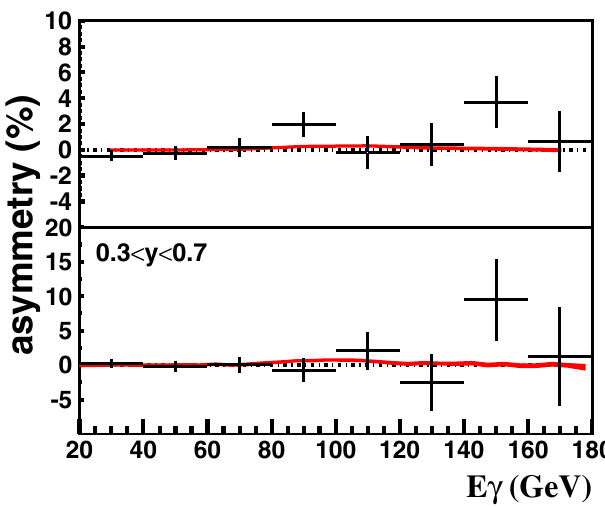
FIG. 17. (Color) Asymmetry measurements without (top) and component of 1 with (bottom) the quasisymmetrical pair selection to determine (cid:2) component of the photon polarization with the diamond 3 analyzer (cf. Table II).